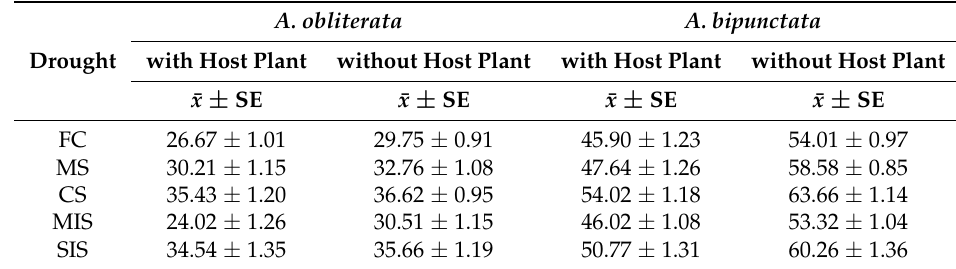
Table 1. Mean consumption rates by adult coccinellids of E. abietinum raised under drought stress in 24 h. FC = field capacity; MS = 60% field capacity; CS = 20% field capacity; MIS = allowed to fluctuate from 70% to 30% field capacity; SIS = allowed to fluctuate from field capacity to 20% field capacity.